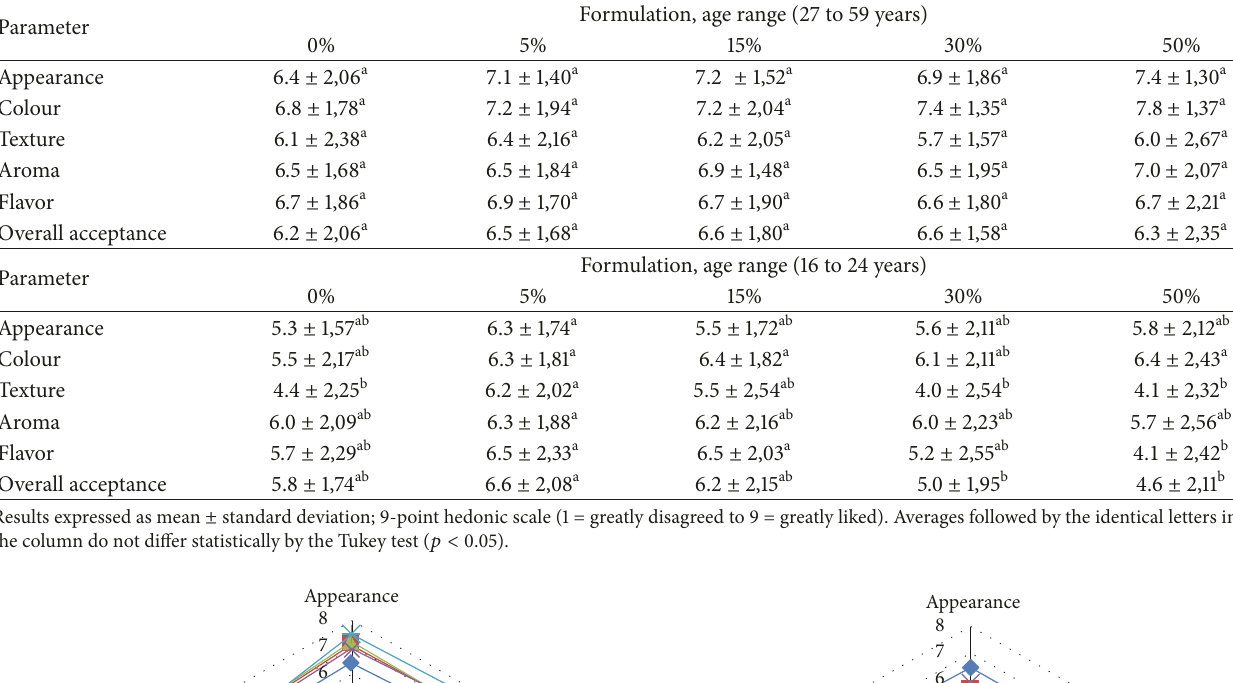
Table 5: Evaluation of the tasting tests of cookie with different formulations.